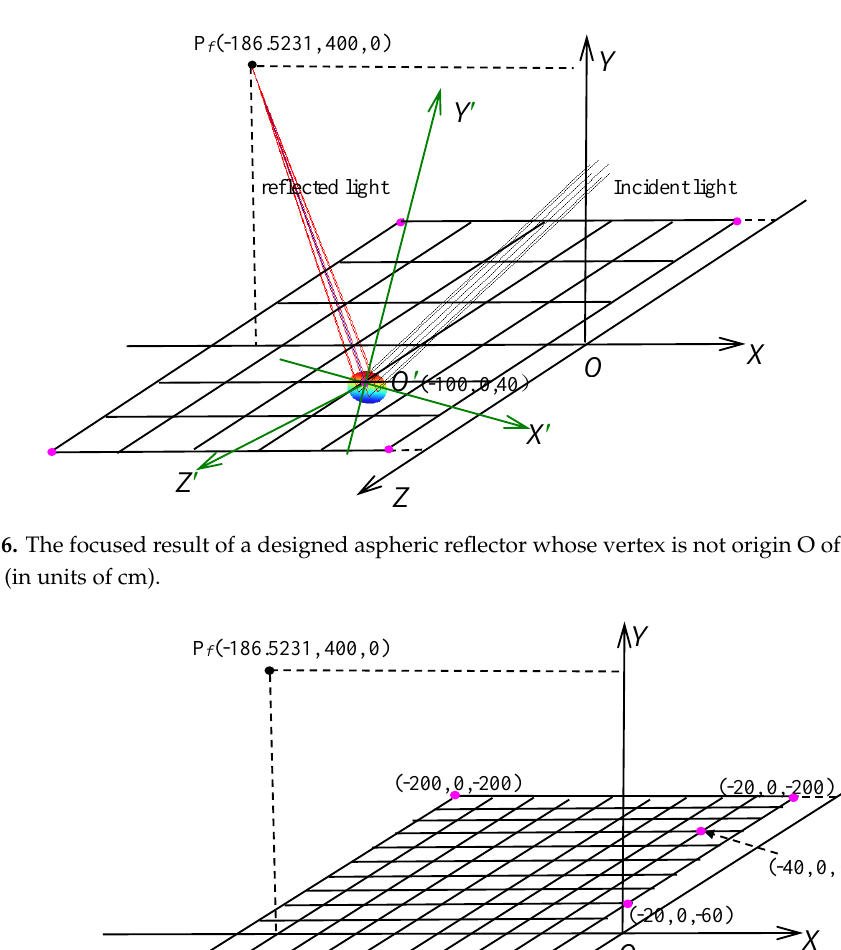
Figure 6. The focused result of a designed aspheric reflector whose vertex is not origin O of the XYZ system (in units of cm).